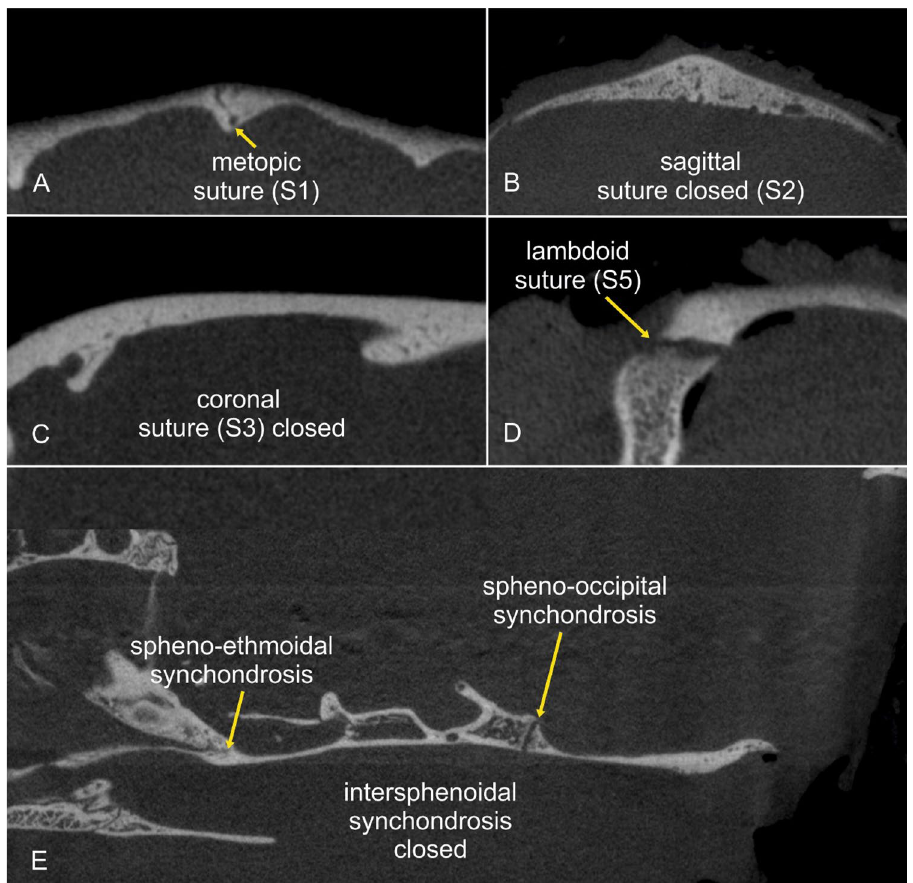
Figure 4. Micro-CT images of a skull specimen of a 12-week-old peke-face Persian cat in a transverse ( A , B ), sagittal ( C , E ) and dorsal view ( D ). The synchondroses separate the adjacent skull bone by a hypodense line of variable shape. The coronal and sagittal sutures are